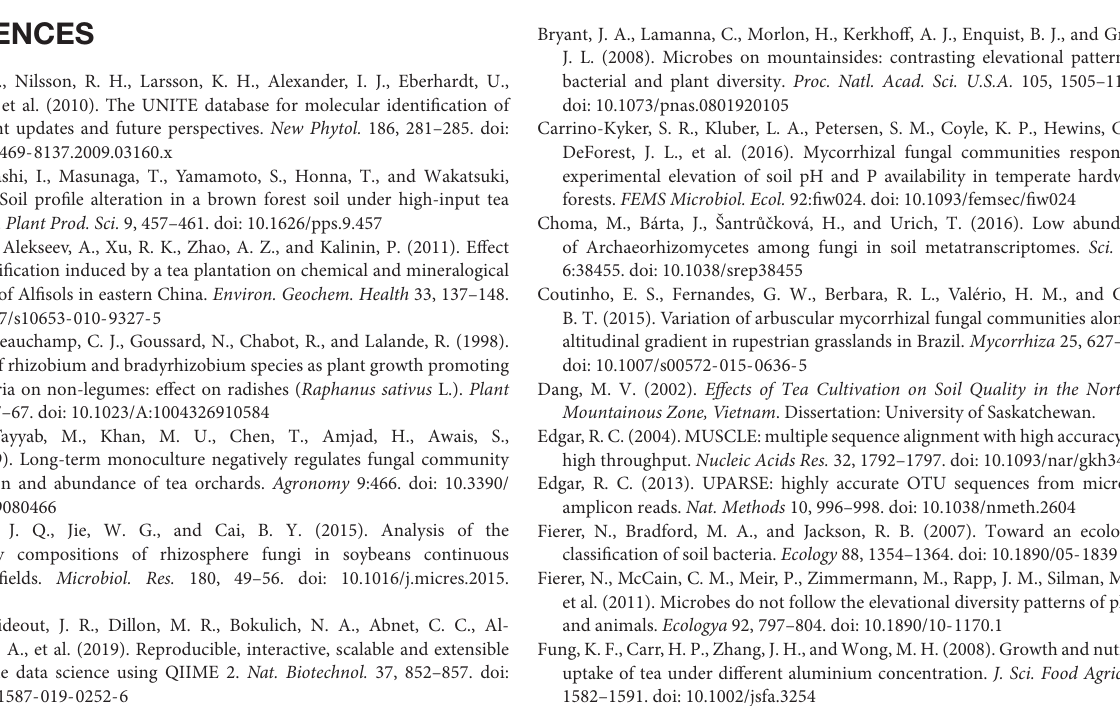
Supplementary Figure S9 | NMDS analysis of soil bacterial (A) and fungal (B) communities in different altitudes groups. Supplementary Figure S10 | UPGMA cluster tree analysis of soil bacterial (A) and fungal (B) communities in different altitudes groups. Supplementary Figure S11 | Relative abundance of soil bacterial and fungal communities in different regions groups. (A) Relative abundance of bacteria at the genus classification level; (B) relative abundance of fungi at the genus classification level. Supplementary Figure S12 | OTUs petal graph analyses of the soil bacterial (A) and fungal (B) communities in in different regions groups. Supplementary Figure S13 | NMDS analysis of soil bacterial (A) and fungal (B) communities in different regions groups. Supplementary Figure S14 | UPGMA cluster tree analysis of soil bacterial (A) and fungal (B) communities in different regions groups. Supplementary Figure S15 | Relative abundance of soil bacterial and fungal communities in 101 ancient tea plantations. (A) Relative abundance of bacteria at the phylum classification level (first 10 bacterial phylum, same below); (B) relative abundance of fungi at the phylum classification level (first 10 fungi phylum, same below). (ATP, ancient tea plantation). Supplementary Figure S16 | Relative abundance and α -diversity indices of soil bacterial and fungal communities in human activity region and human inactive region. (A) Relative abundance of bacteria at the phylum classification level; (B) relative abundance of fungi at the phylum classification level; (C) Chao1 and Shannon indices of bacteria and fungi. Different lowercase letters indicate significant differences between subgroups ( P < 0.05). (HAR, human activity region; HIR, human inactive